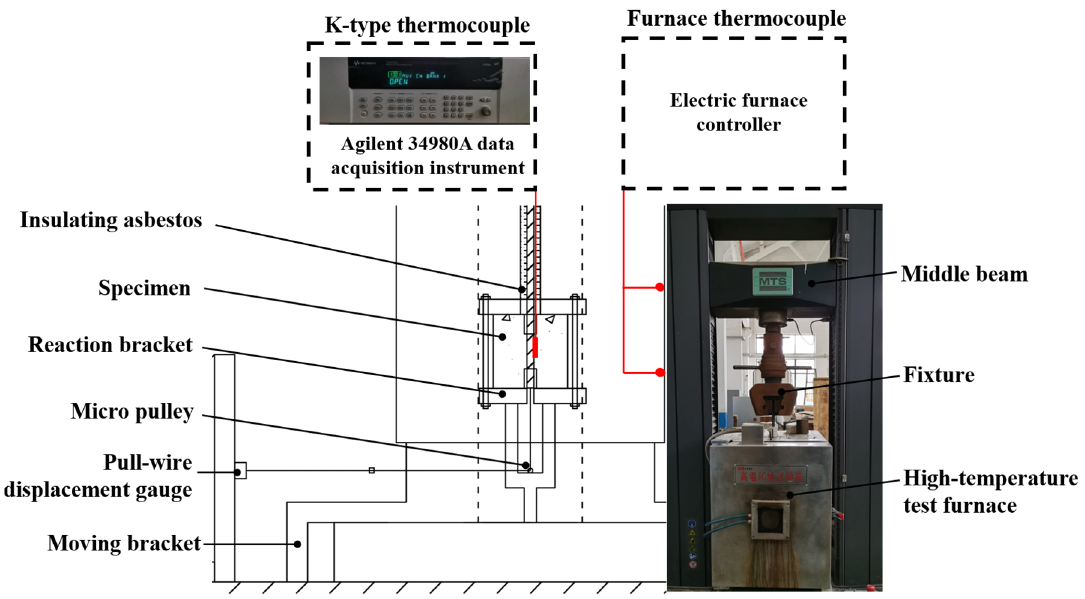
Figure 4. Loading device.